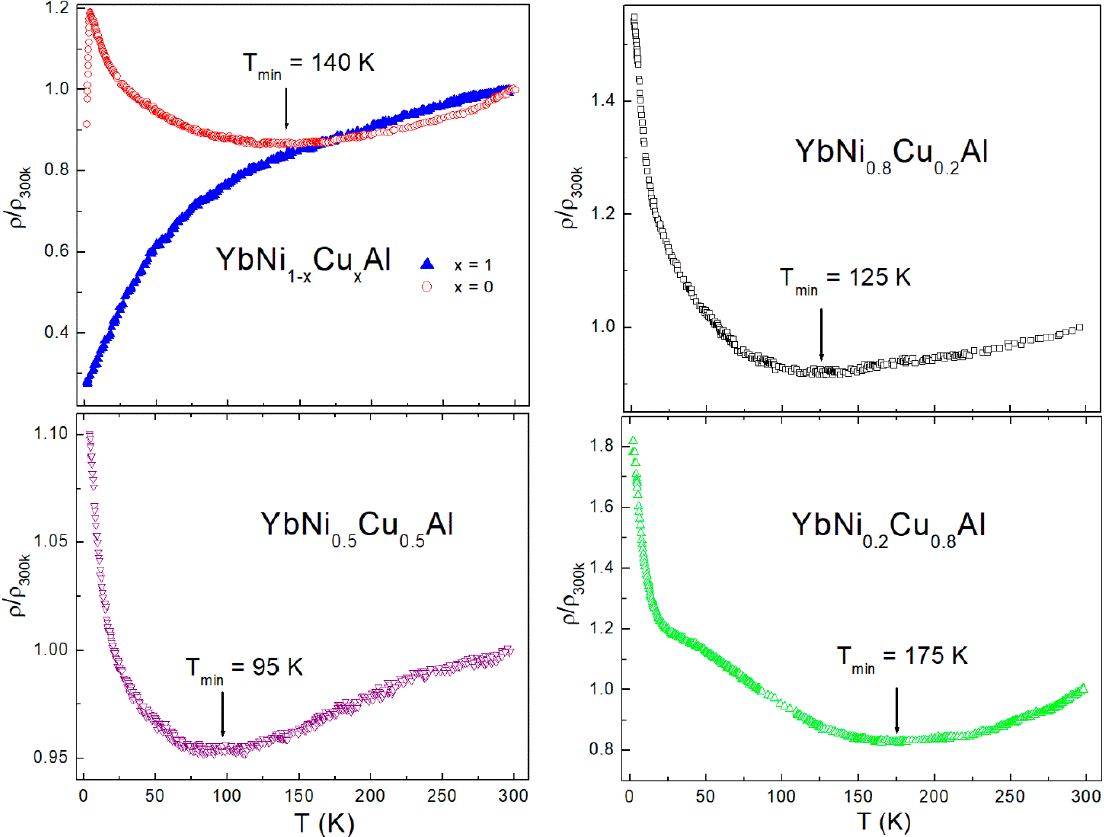
Figure 4. Temperature dependence of the electrical resistivity of the YbNi1 − xCuxAl series of alloys in normalized form ( ρ / ρ 300K ). The minimum in the electrical resistivity associated with the Kondo effect is marked with an arrow, except for x = 1, where a Kondo lattice behavior is observed.